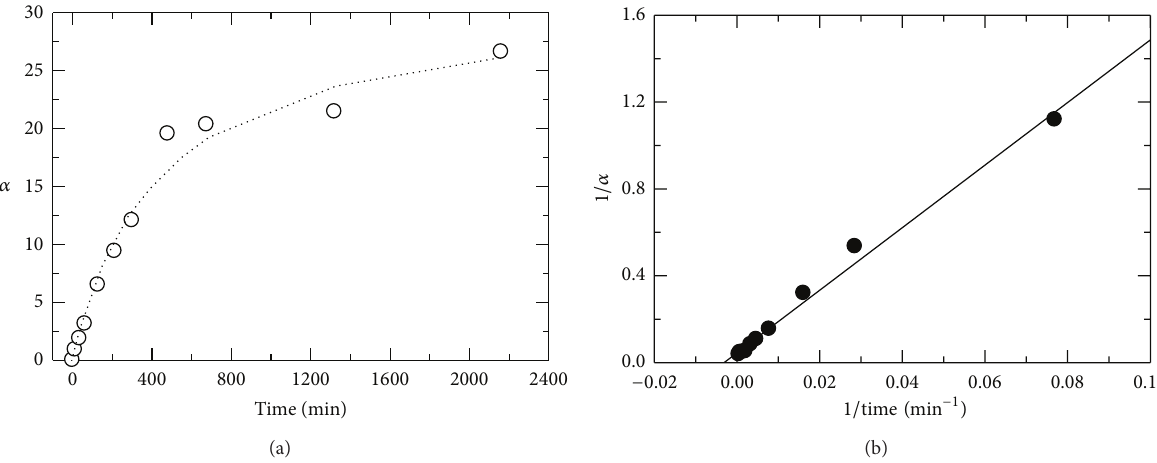
Figure 4: (a) Average number of chain scission, 𝛼 , as a function of reaction time (0–2400 min) at 65 ∘ C. Open circle shows experimental points (O), and dotted line shows curve fit; (b) reciprocal of chain scission versus reciprocal of reaction time (0–2400 min). Chitosan concentration was 1.0% (w/v) in 0.1M HAc.